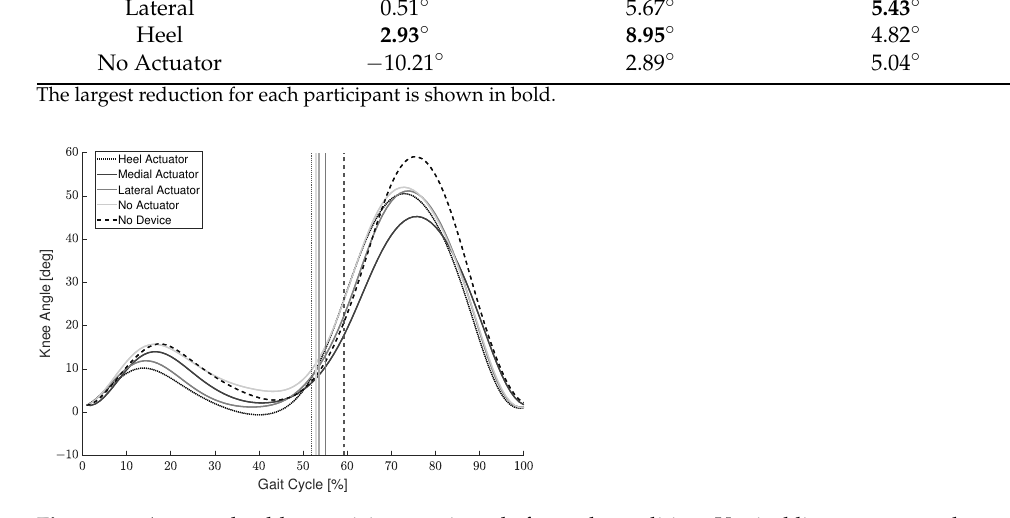
Figure 10. Average healthy participant gait cycle for each condition. Vertical lines represent the end of the stance phase.